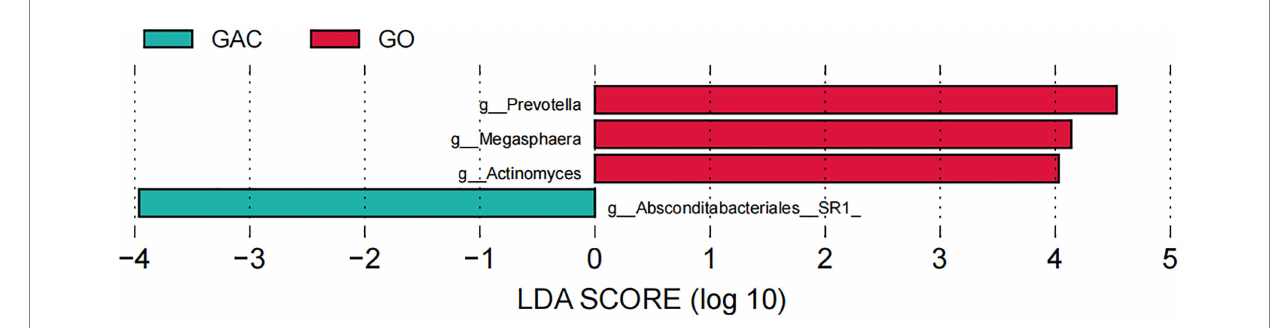
FIGURE 4 LEfSe analysis of GJM in GO and GAC subgroups of HP+